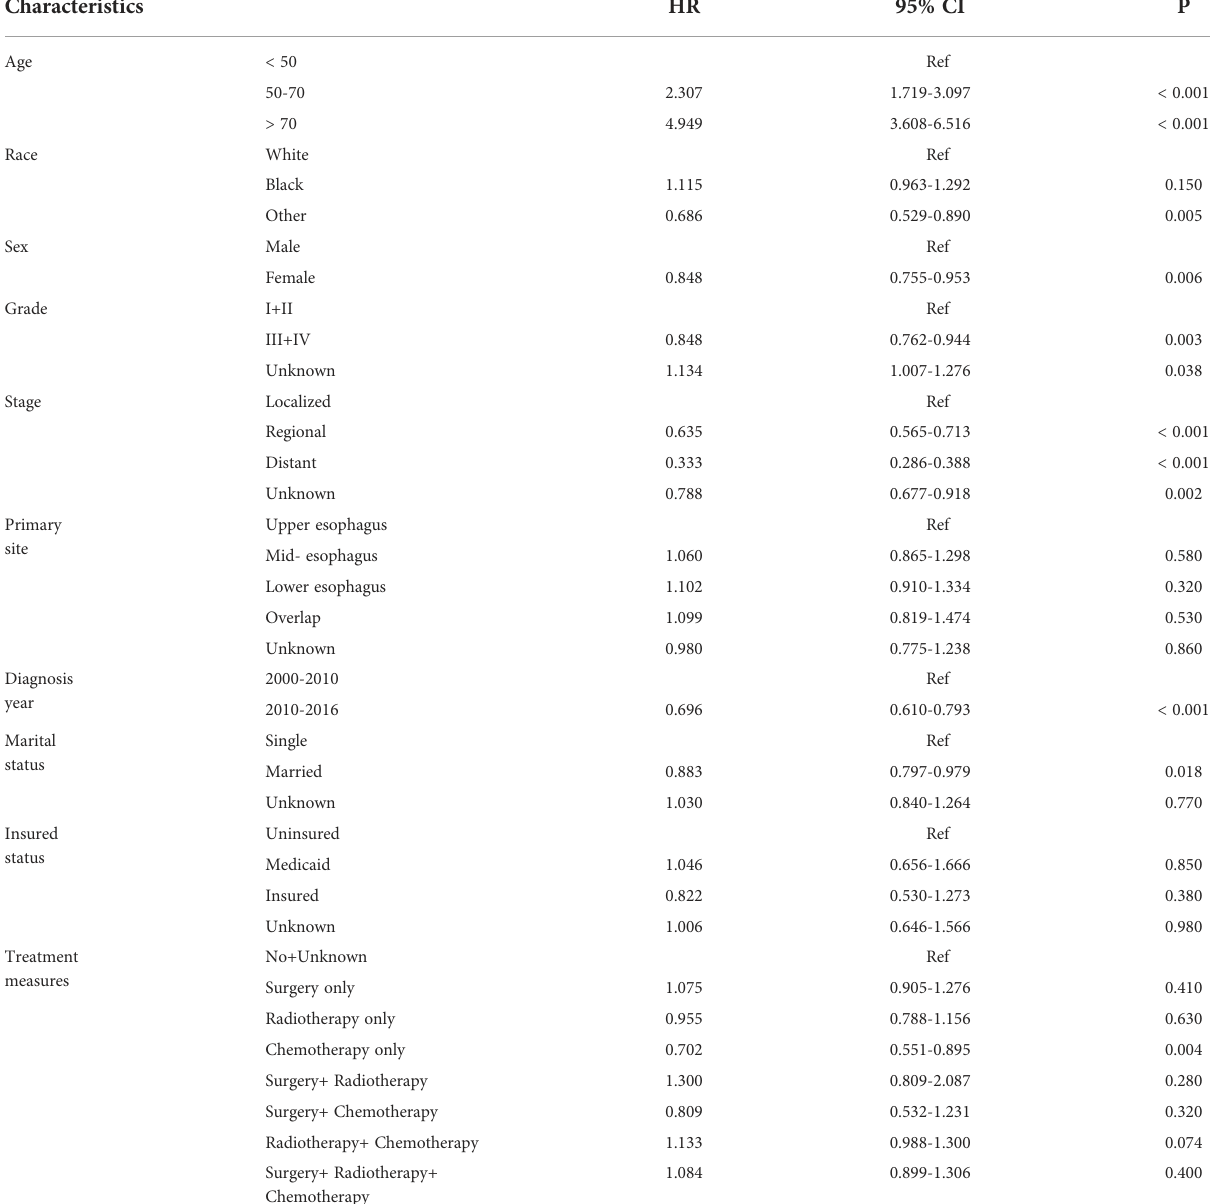
TABLE 5 Effects of comprehensive treatment measures on CVD related death in EC patients.